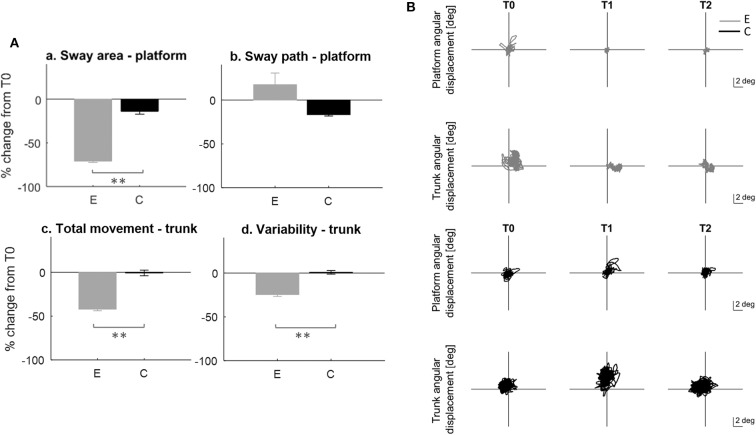
Dynamic balance test on unstable platform. (A) Rate of improvement T0-T1; E, experimental group; C, control group. a: sway area; b: sway path; c: trunk total angular displacement; d: standard deviation of the trunk acceleration. Error bars indicate standard error; * indicates a p-value between 0.01 and 0.05, while ** indicates p < 0.01. (B) Example of platform (rows 1, 3) and trunk (rows 2, 4) angular displacement raw data for two subjects, one from the experimental (gray line) and one from the control (black line) group at T0, T1, T2.